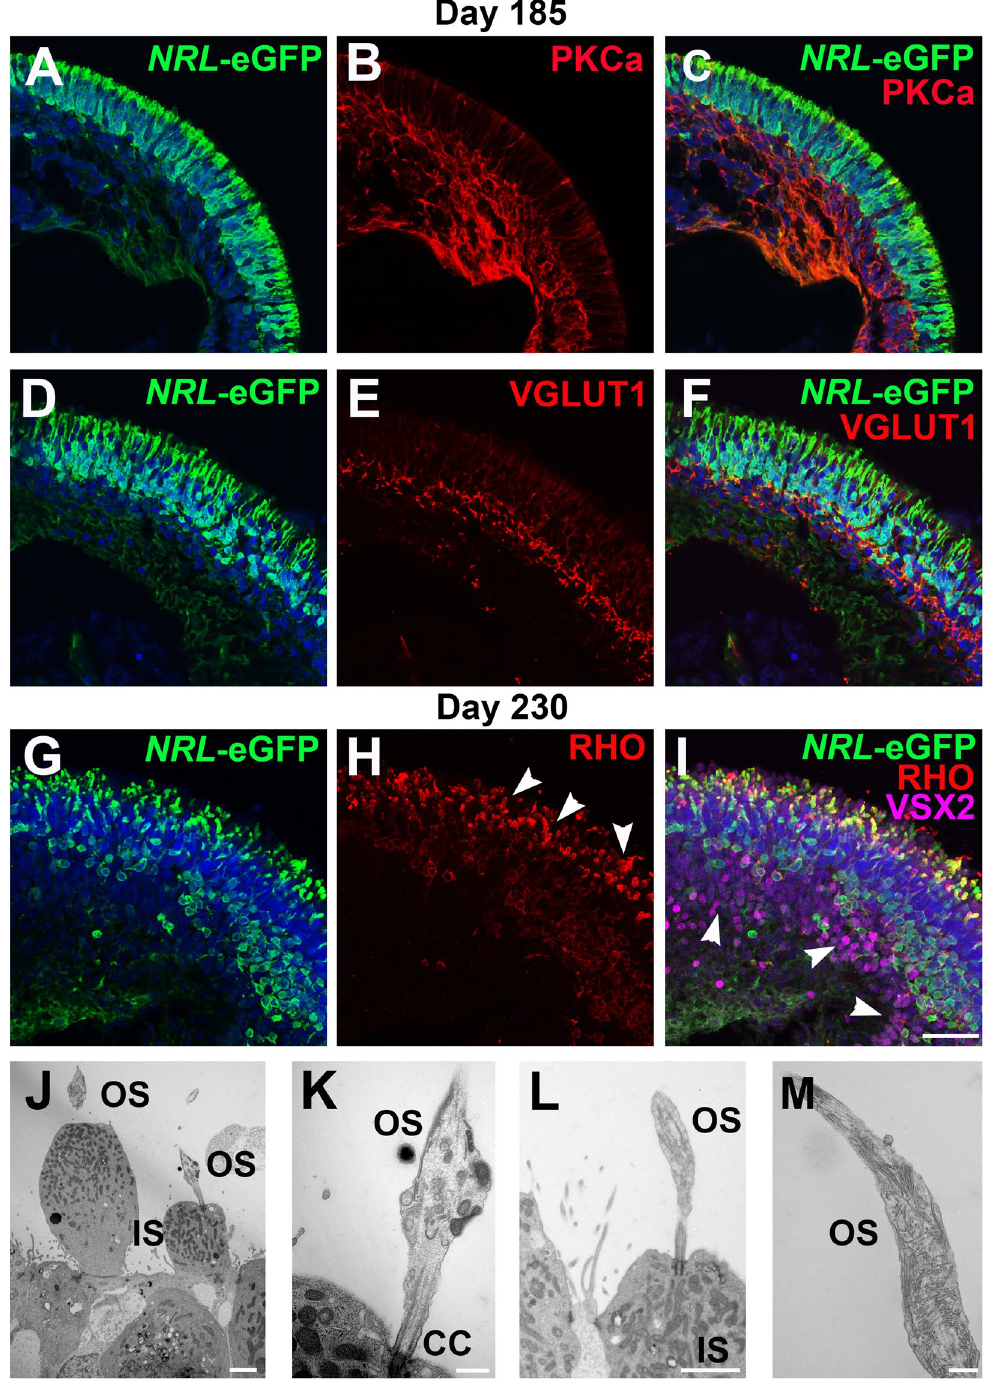
Figure 6. eGFP labeling of rods in mature NRL + /eGFP OVs. To examine late stages of rod differentiation in NRL + /eGFP OVs, d185 and d230 OVs were analyzed. ( A – C ) At d185, PKC α (a rod bipolar cell marker) was detected beneath the layer of NRL -eGFP + rods, consistent with the development of an inner nuclear layer. ( D–F ) NRL -eGFP + rod terminals co-labeled with the synaptic protein VGLUT1 within a discrete outer plexiform layer. ( G – I ) At d230, RHO immunolabeling was found in rod outer segment-like projections (arrowheads in H ) that co-expressed NRL -eGFP (merged image in I ). VSX2, a marker of rod and cone bipolar cells, was found beneath the layer of NRL -eGFP + rods (arrowheads in I ), demonstrating maintenance of an inner nuclear layer at late stages of differentiation. ( J – M ) Representative transmission electron micrographs of showing photoreceptor outer segments (OS) and mitochondria-rich photoreceptor inner segments (IS) linked by a connecting cilium (CC) along the outside of NRL + /eGFP OVs at d230. Scale bar in I = 50 µ m; J,L = 2 µ m; K,M = 500